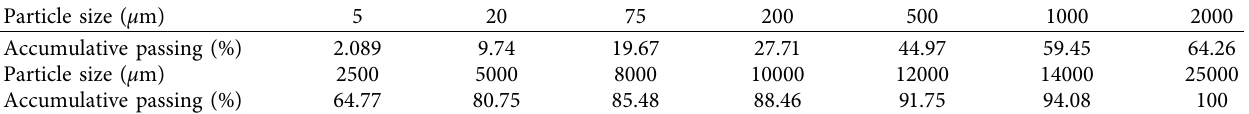
Table 4: Particle size distribution of the Gobi